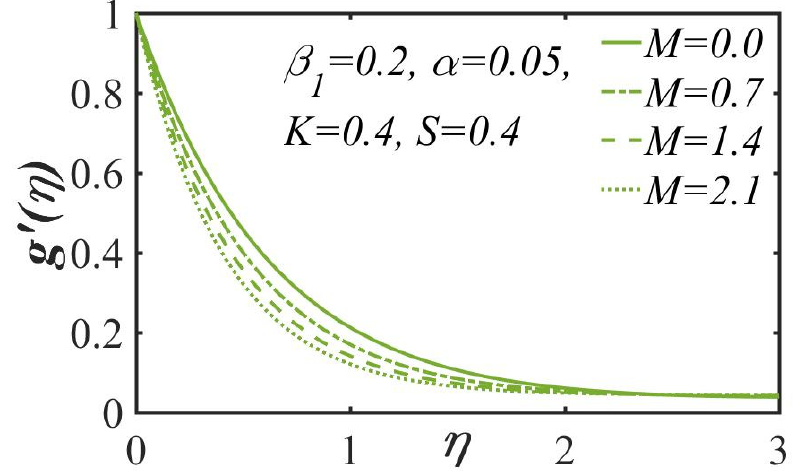
Figure 2. Velocity magnitude for M .